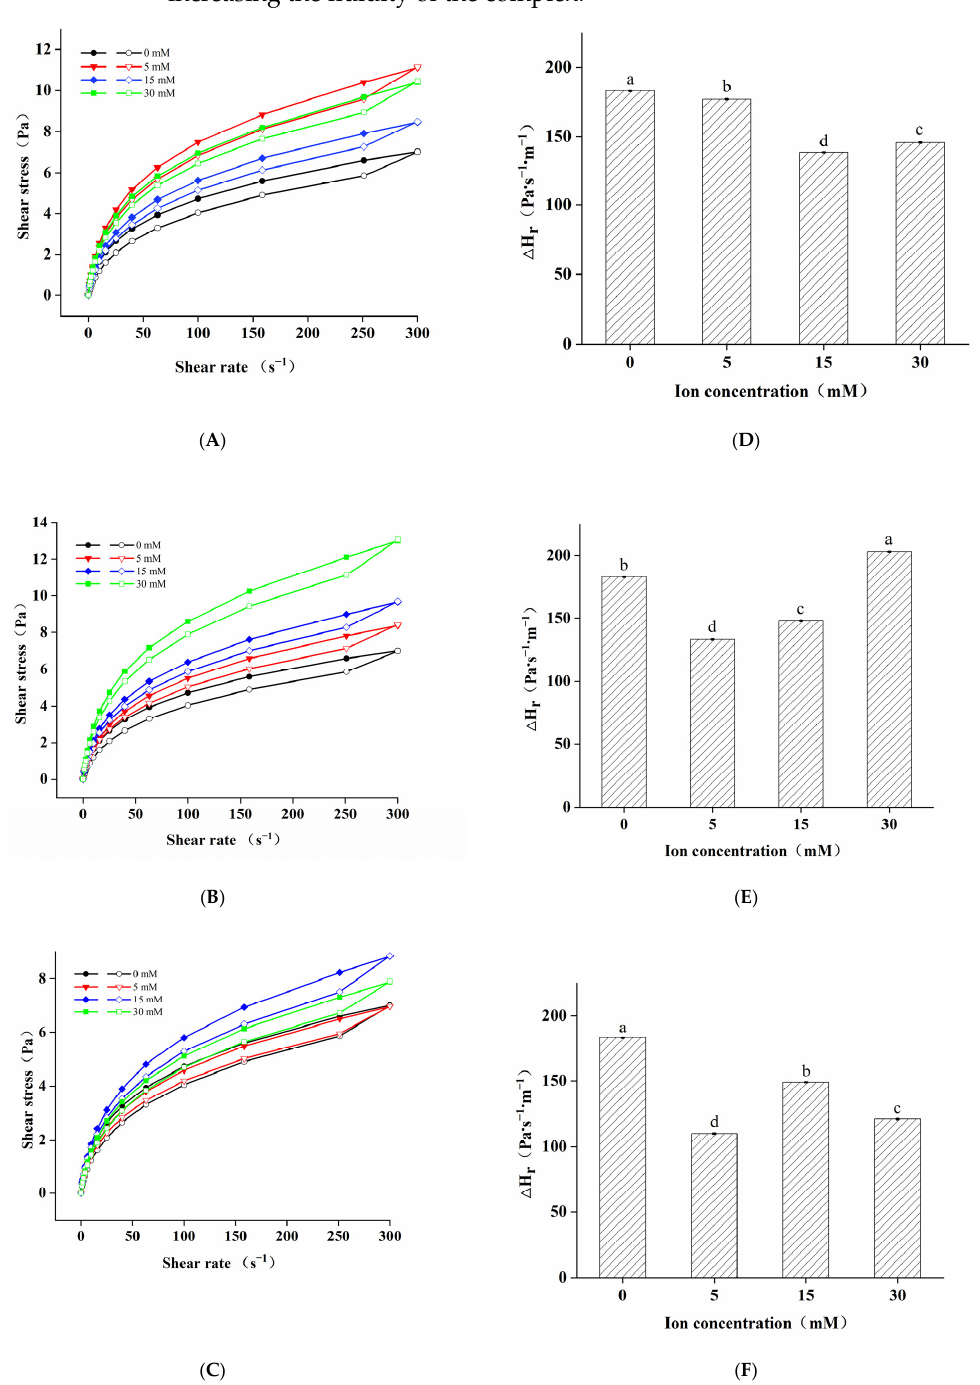
Figure 3. Steady-shear flow properties of the low methoxyl pectin/sodium caseinate (LMP/CAS) complex. Shear stress and hysteresis loop area of Na + –LMP/CAS ( A , D ), K + –LMP/CAS ( B , E ), and Ca 2+ –LMP/CAS ( C , F ). Different letters above the bars indicate a significant difference ( p <